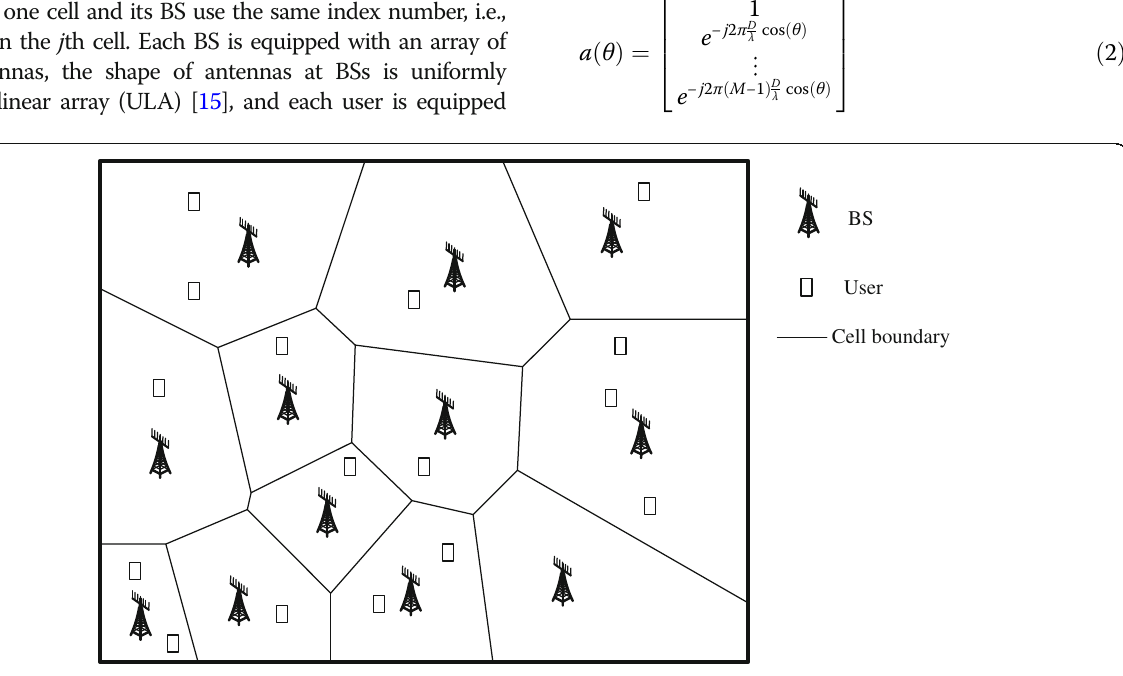
Fig. 2 A massive MIMO system with irregularly shaped cells and randomly located